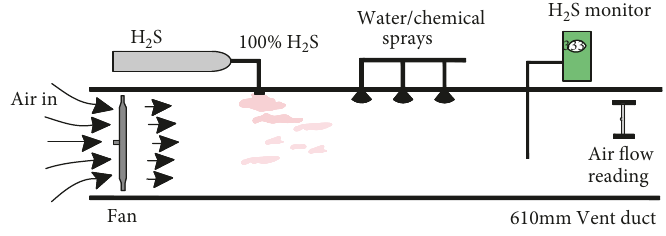
Figure 16: Setup for H 2 S spray tests.